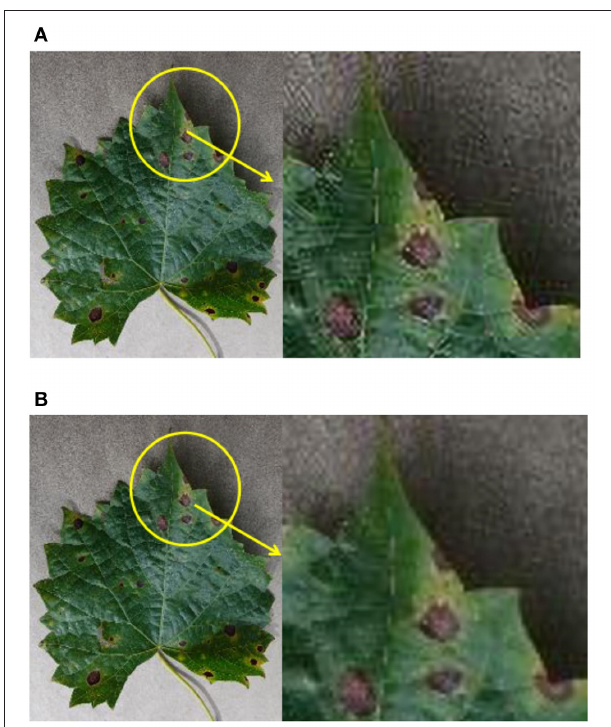
FIGURE 4 | The comparison of the original image and the enhanced image. (A) The original image. (B) Super-resolution enhanced